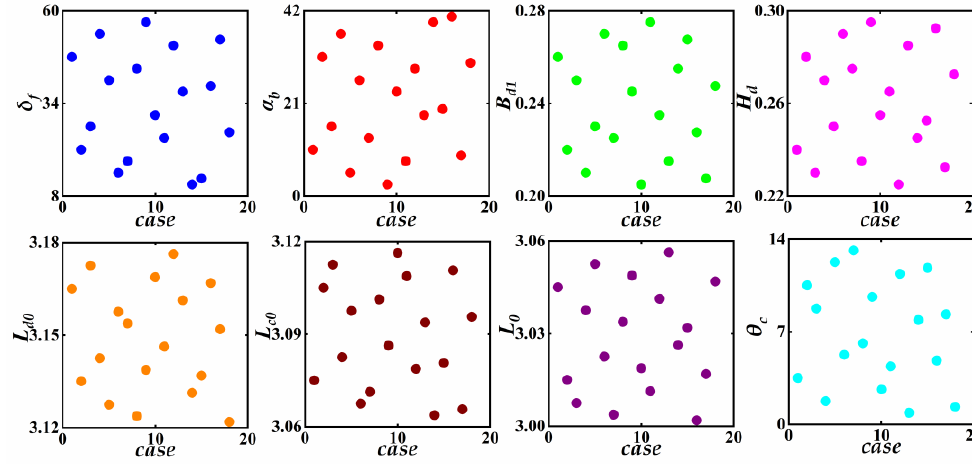
Figure 22. Distribution of design variables in space. Table 8. The hydrostatic data corresponding to each